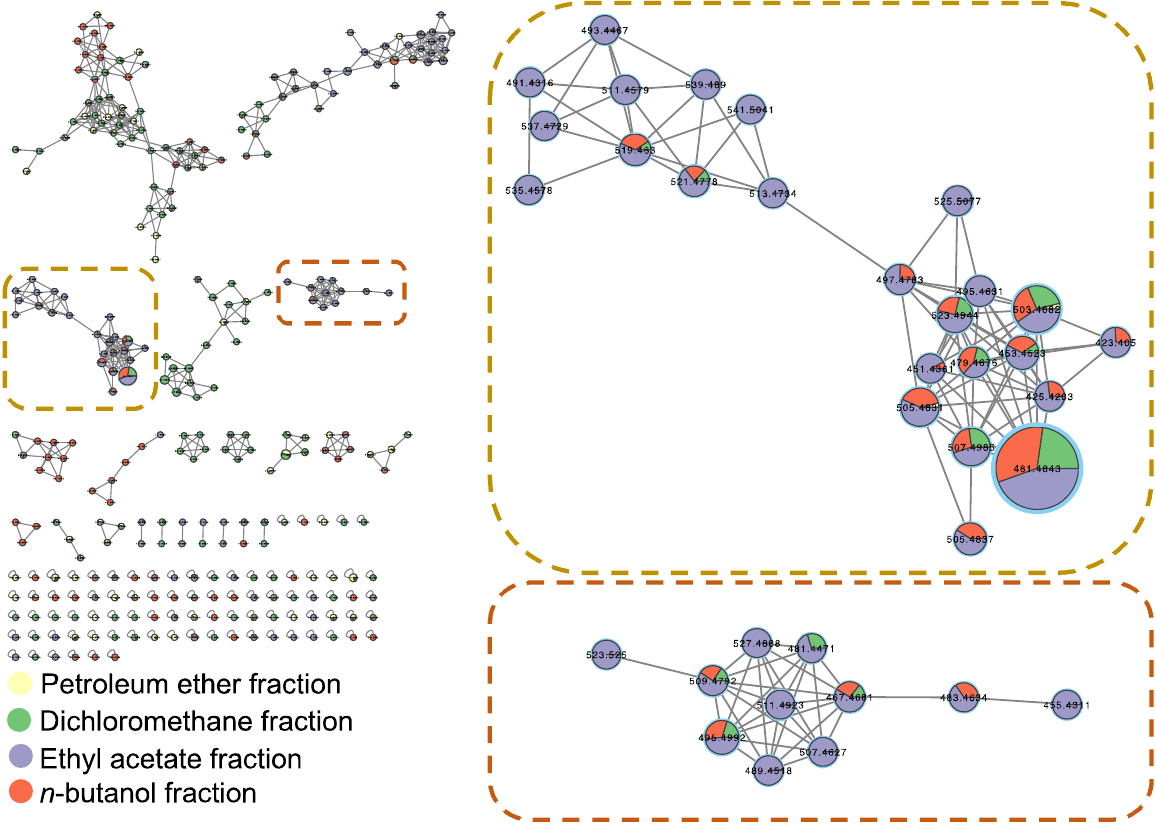
Figure 4. GNPS molecular network of different fractions of A. lucidior ethanolic extract in the positive ion mode. Each node is displayed as a pie chart representing the relative abundance of the metabolite with different colors in different fractions. The node label represents precursor mass ( m / z ). The node size represents the sum of precursor ion intensity.